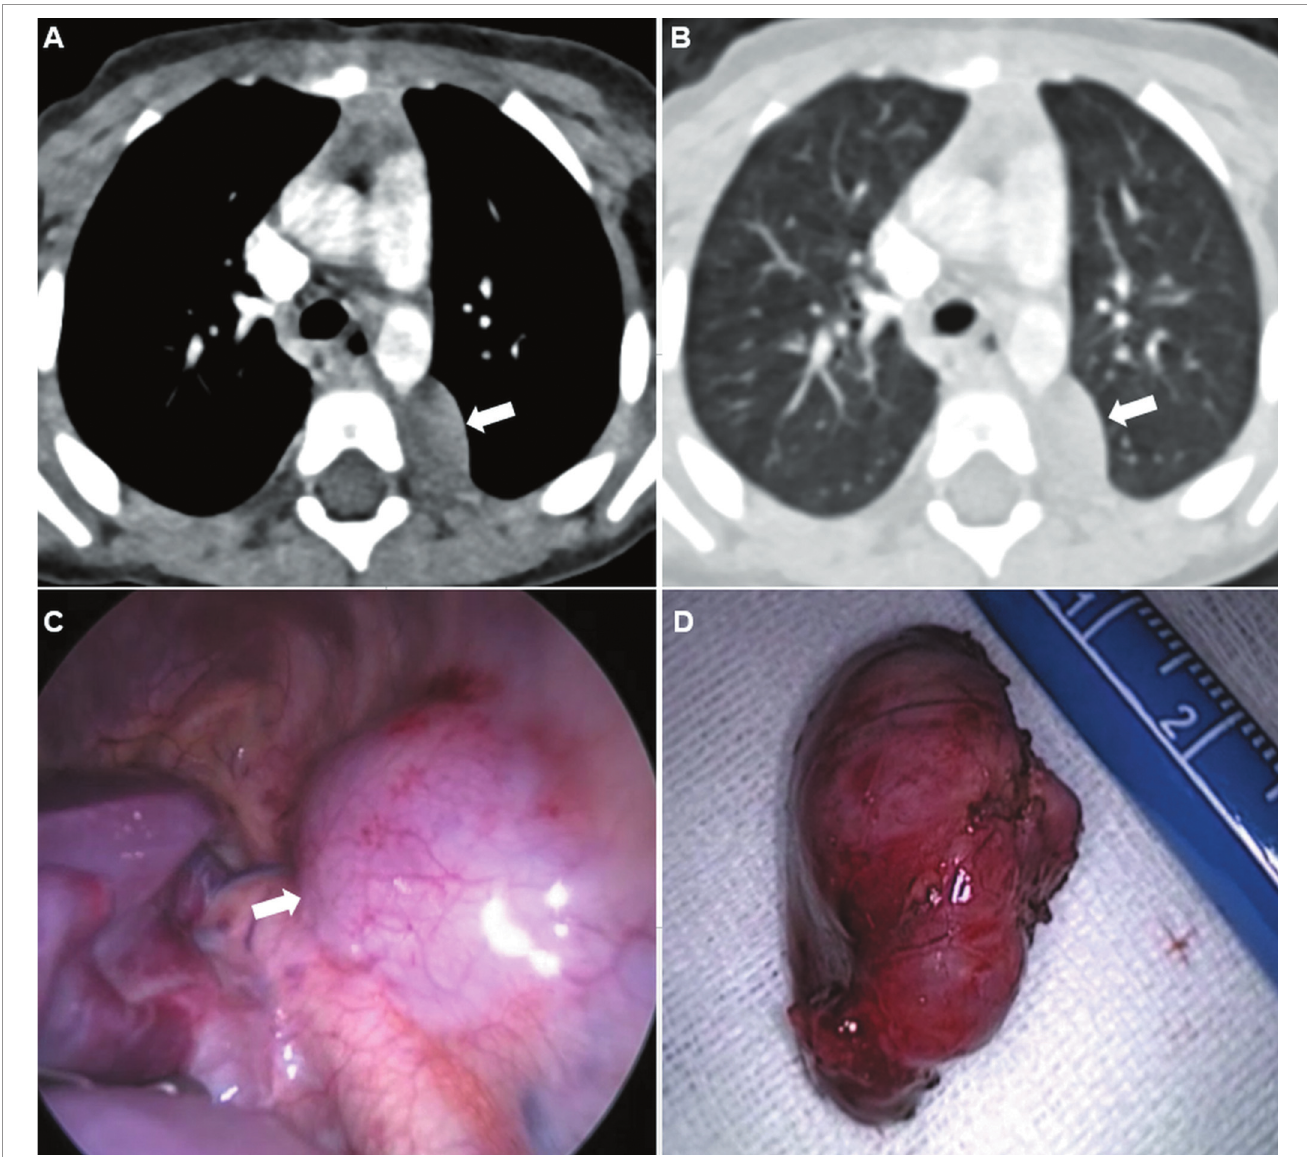
Figure 1. A 2-year-old male patient has a soft tissue density of approximately 23 × 13 mm in the posterior mediastinum in the left posterolateral part of the aorta on thoracic CT (A, B). The lesion was thoracoscopically resected (B, C). Ganglioneuroblastoma was detected in the histopathological examination of the mass